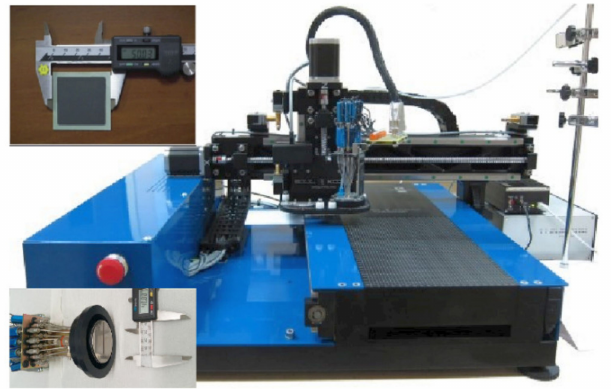
Figure 1. Customised inkjet printing system used for the infiltration experiment (the insets show the 16-nozzle Domino valve-jet print head and the commercial anode-supported